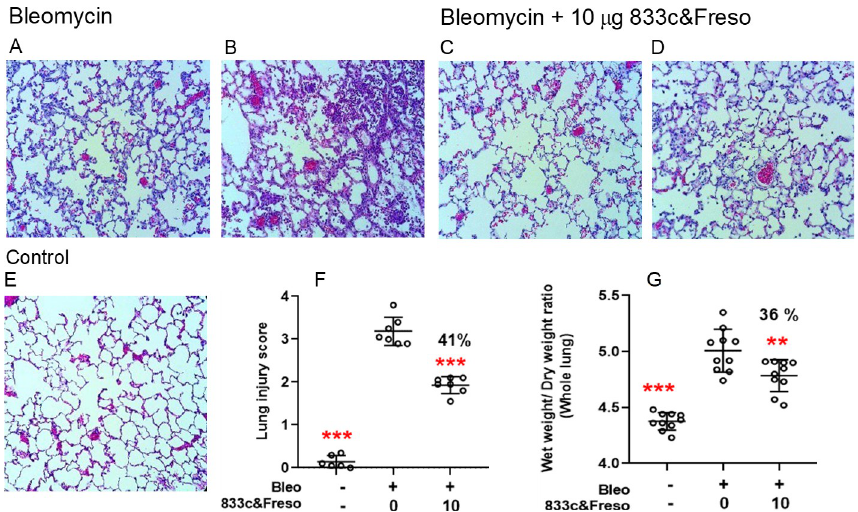
Fig 4. Therapeutic effect of 833c&Freso on lung pathology and edema from bleomycin. Rats were treated with 10 μ g/kg 833c&Freso iv on day 2 after bleomycin challenge. Lungs excised on day 3 were sectioned and stained with H&E. Light microscopy images ( × 20) showing lung histopathology (A-D) vs. normal (E) . Tissue damage was clearly evident but varied within each group, ranging from low (A, C) to high (B, D) . (F) Lung damage in each 20x microscopy field was scored as described in Methods. (G) Wet to dry lung weight ratio, n = 10 total rats per group. Scatter graphs indicate means ± SD. Percentage (%) inhibition of lung injury scores (F) and edema (G) is indicated. �� P < 0.01, and ��� P < 0.001 were obtained vs bleo control by one-way ANOVA followed by Dunnett’s